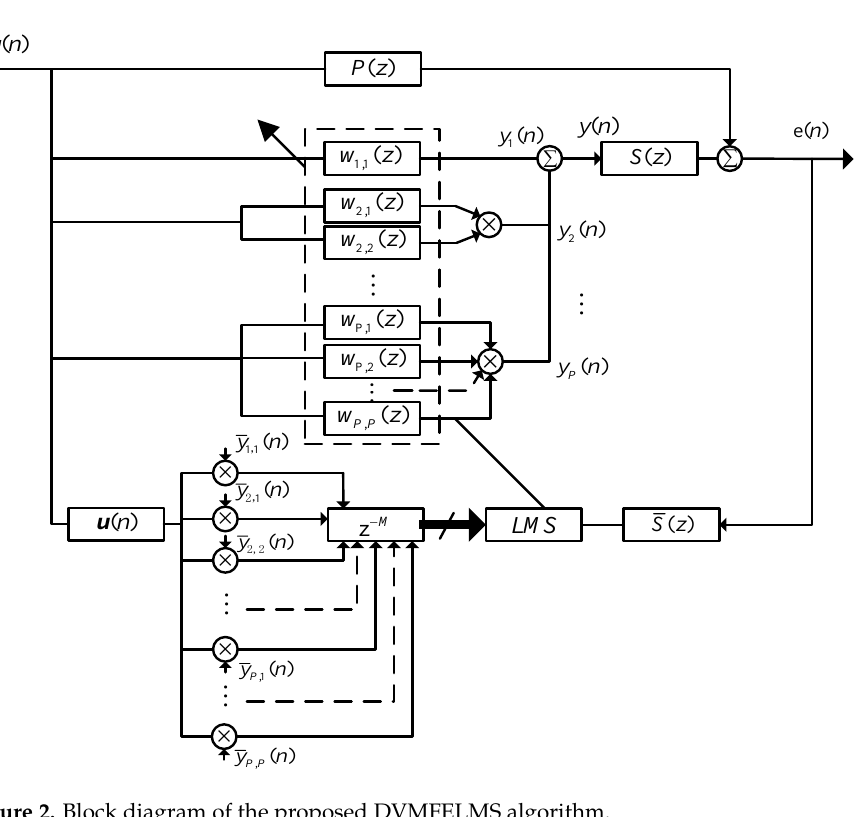
Figure 2. Block diagram of the proposed DVMFELMS